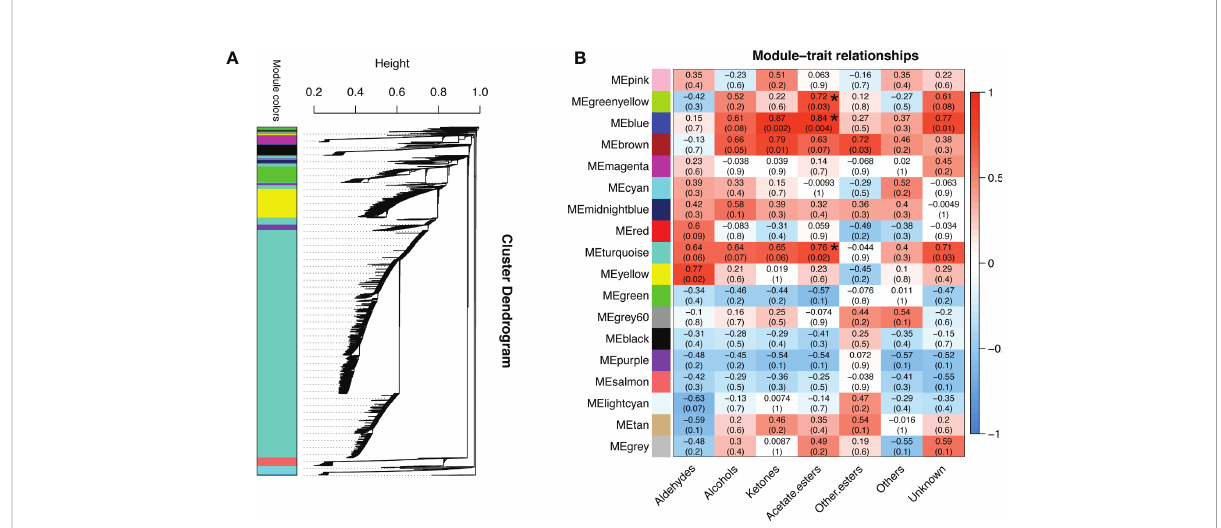
FIGURE 5 Analysis of gene co-expression and the relationships between genes and volatile content in response to cold storage. (A) Hierarchical cluster tree exhibits 18 modules of co-expressed genes. Each branch represents one gene in the tree. (B) Module-trait correlations and gene co- expression network analysis performed by weighted gene co-expression network analysis during cold storage. The green-yellow, blue and turquoise modules with asterisks signi fi cantly related to the content of volatile acetate esters. The corresponding p -values are shown in parentheses. The left to right panel represents the module-trait correlations from -1 to